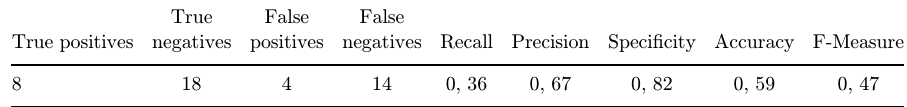
Table 1. Answer correctness and performance